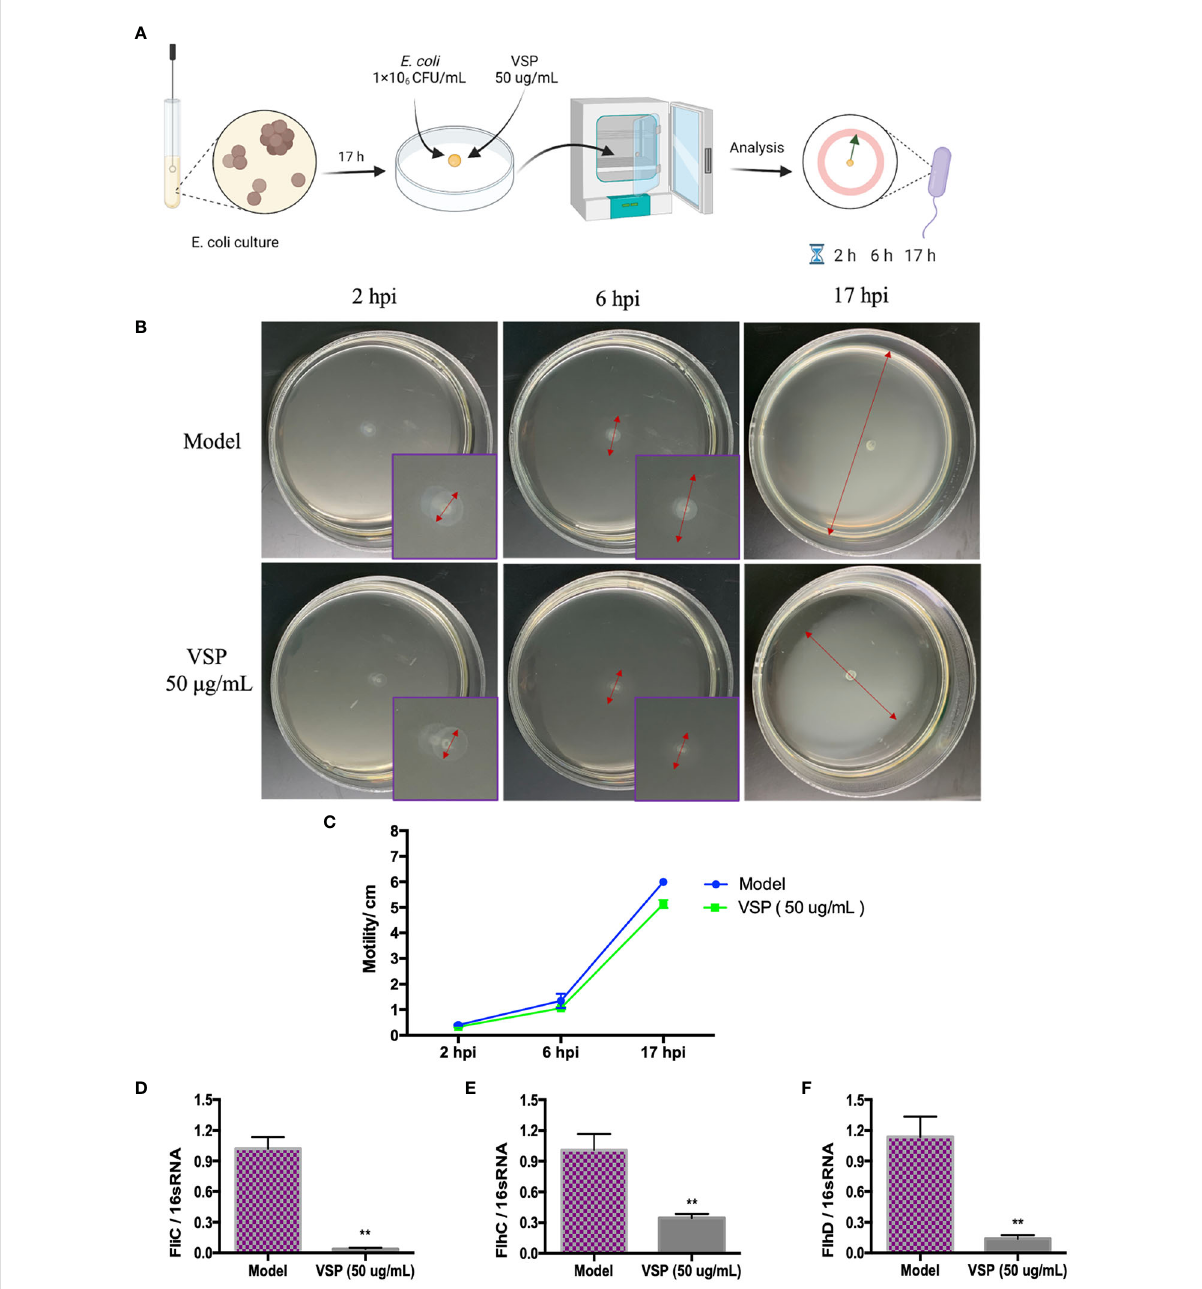
FIGURE 4 VSP inhibited the motility of UPEC CFT073. (A) , a scheme of the ( E ) coli infection and VSP administration. (B) , The motility of UPEC CFT073 in soft agar. The symbol in this graph represents the swimming motility diameter of UPEC CFT073. (C) , The zone of swarming was measured after 2 hours, 6 hours, and 17 hours. Each data point in the line graph indicates the means of six replicates. (D-F) , The relative transcript levels of fl iC, FlhC and fl hD after the VPS intervention, assessed by RT-PCR with 16S RNA as the internal control. n =4, compared with the control group. Compared with the model group: ** p < 0.01, the results were determined by one-way ANOVA followed by Dunnett ’ s post hoc